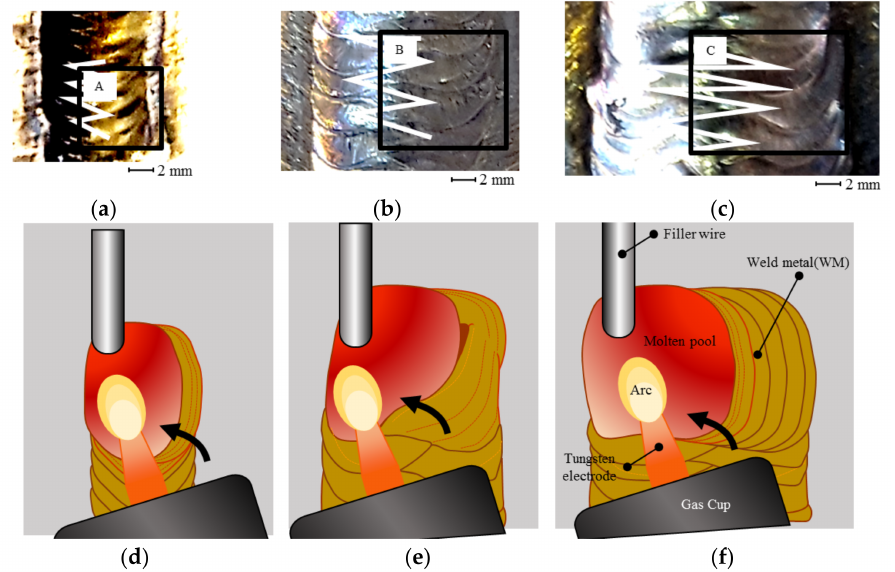
Figure 2. Bead appearance and schematic of molten pool movement by weaving: bead surface ( a ) Low heat input; ( b ) medium heat input; ( c ) high heat input; schematic diagram of ( d ) low heat input; ( e ) medium heat input; and ( f ) high heat